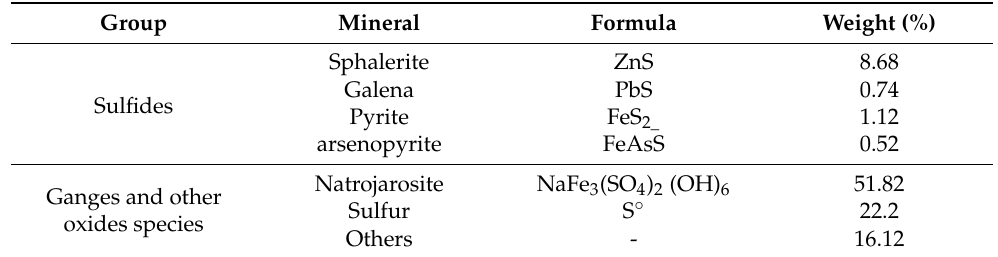
Table 2. Results of the analysis of association and chemical composition of the DLR by the SEM-MLA system.